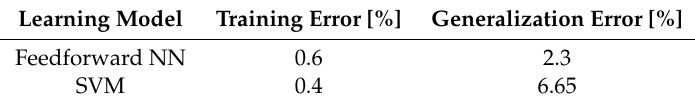
Table 4. Comparison of classification errors by the ANN and the